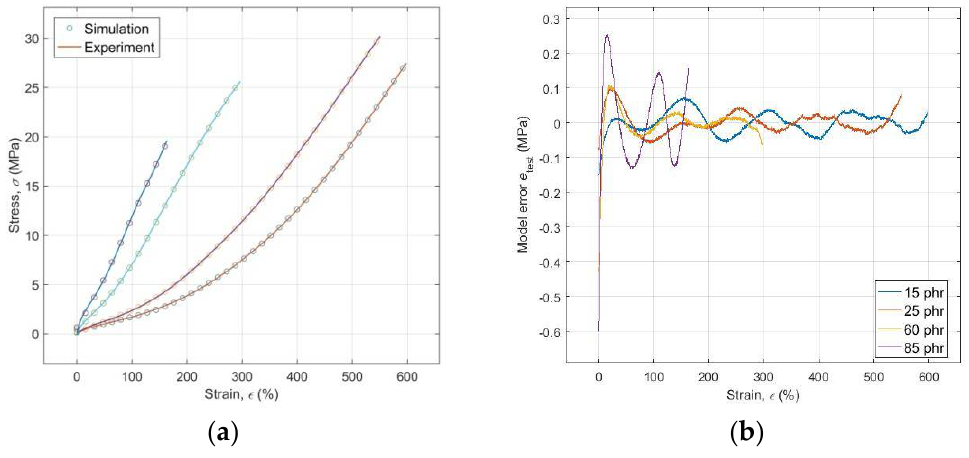
Figure 7. ( a ) Comparison of experimental and simulated data; ( b ) Model error plot.